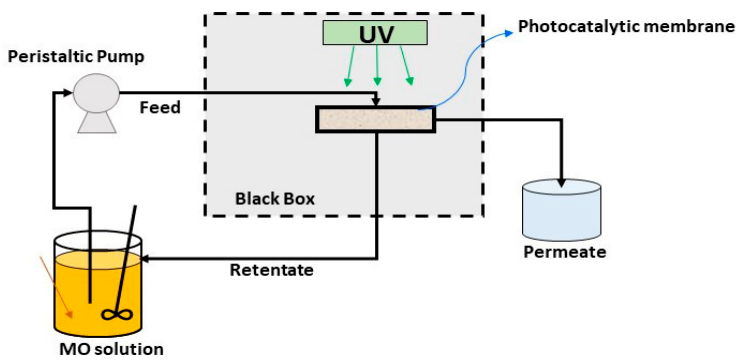
Figure 2. Scheme of the PMR used for MO degradation.